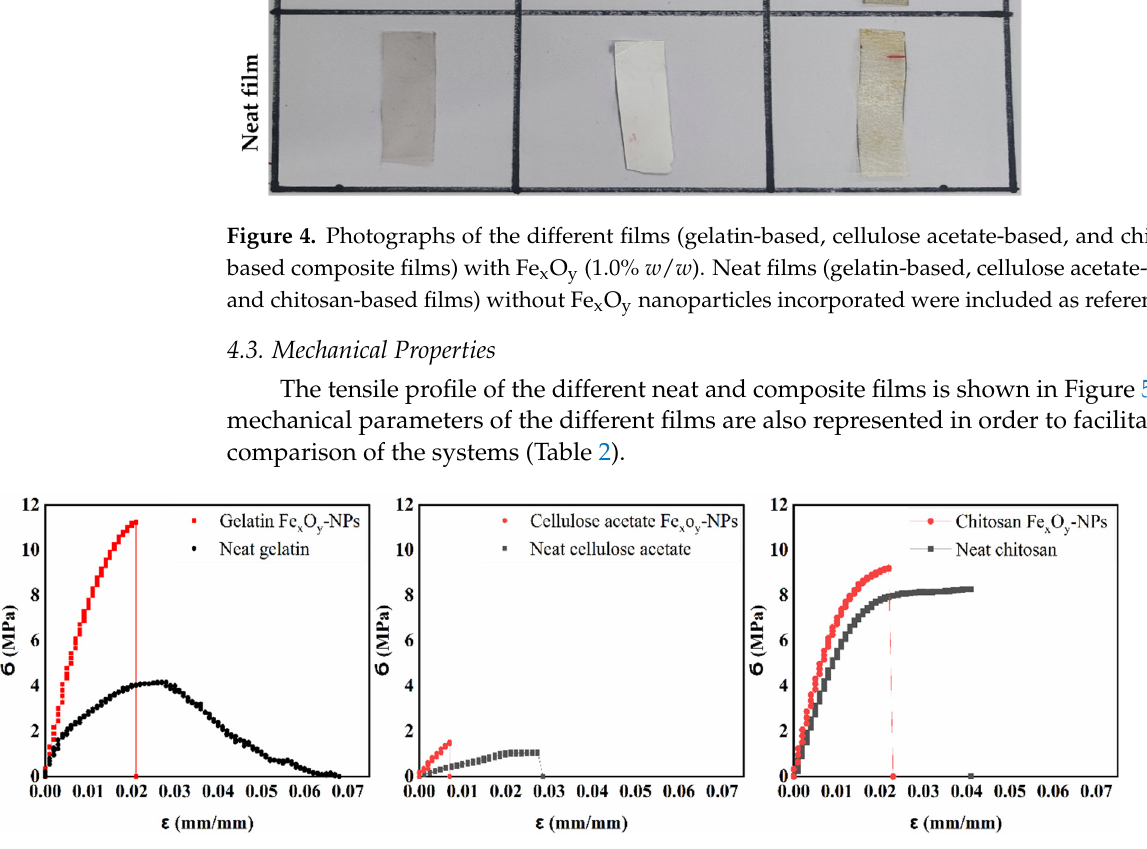
Table 2. Results for thickness, mechanical parameters ( Ϭ max , ε max , Ε , and toughness), and antioxidant